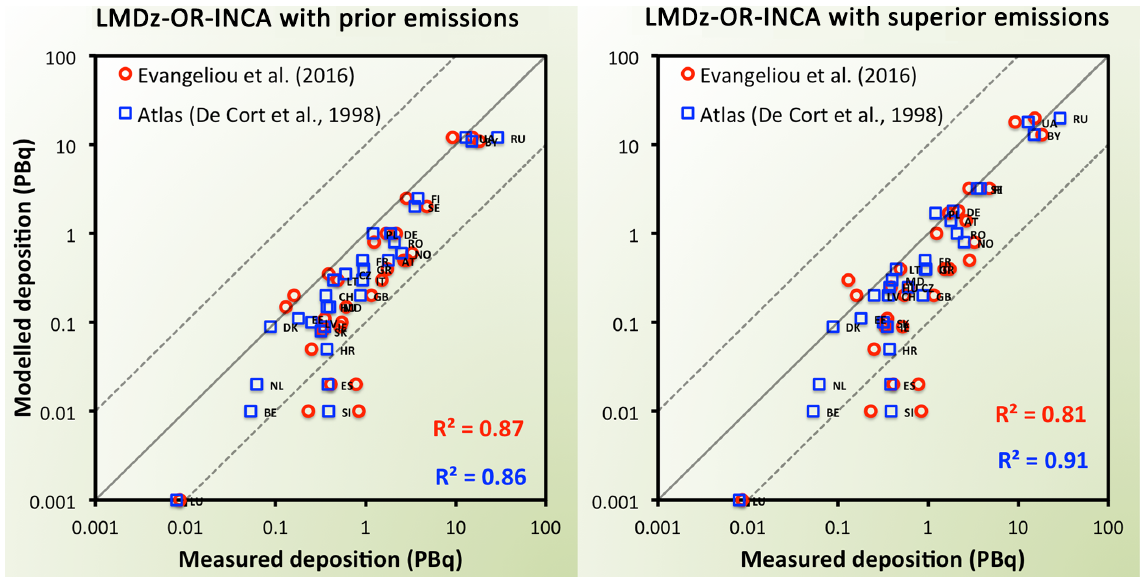
Figure 11. Country-by-country total cumulative simulated deposition of 137 Cs simulated with LMDz-OR-INCA model using the prior and the posterior emissions vs. the corresponding values estimated based on data from the Atlas (De Cort et al., 1998) and from Evangeliou et al. (2016). The different countries are named as in Fig.